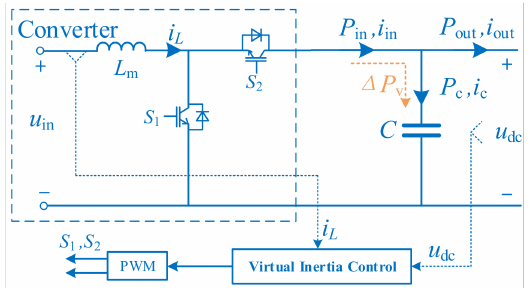
Figure 9. Power relationship of dc-link capacitor side, considering the virtual inertia